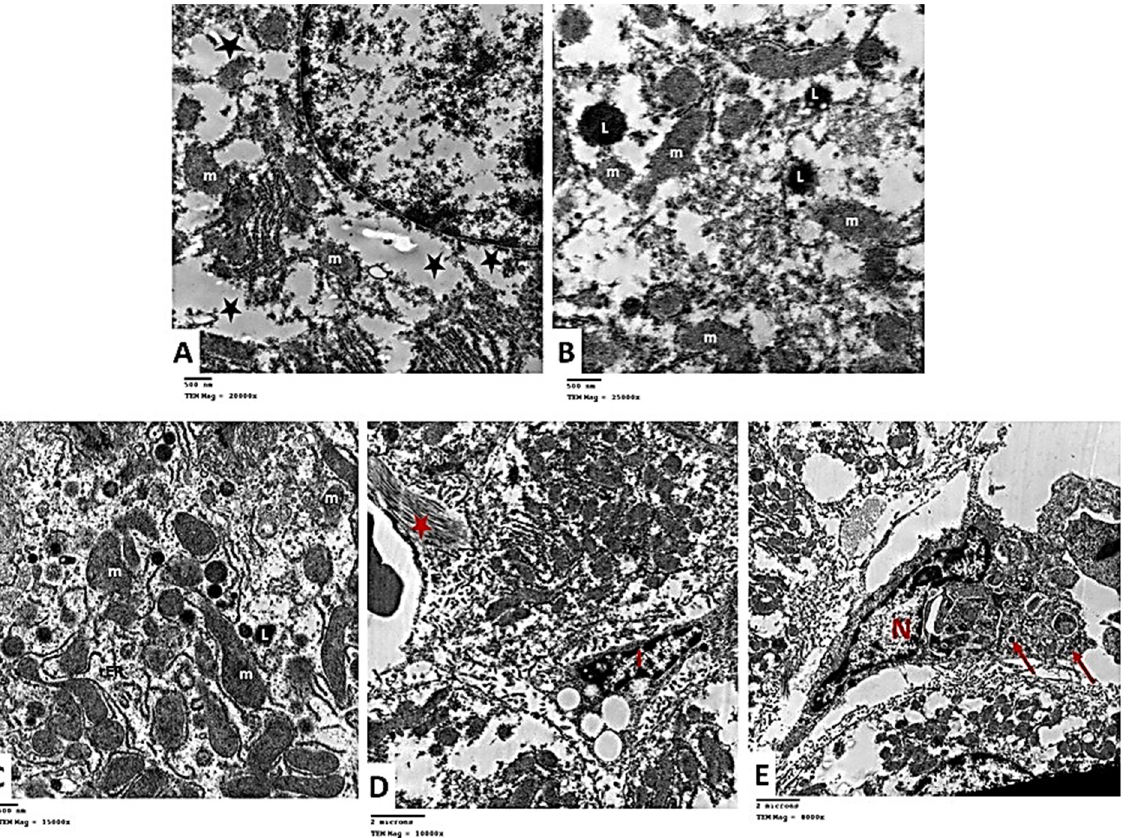
Figure 12. ( A ) Electron micrographs of Group II showing homogenous echogenic areas in hepatocyte cytoplasm (*). TEM × 20,000. ( B ) Electron micrograph showing the apparent decrease in rER and glycogen rosettes. Many lysosomes (L) are seen scattered in the cytoplasm. Mitochondria (m) are seen with an ill-defined outer membrane. Degeneration and lysis of the organelles are also noticed. TEM × 250,000. ( C ) showing swollen mitochondria (m), which lose their cristae. Expansion of rough endoplasmic reticulum (rER) is seen with loss of the attached ribosomes. TEM × 15,000. ( D ) Electron micrograph showing hepatic stellate cell or Ito cell (I) containing fat droplets in its cytoplasm. Notice the collagen fibers with their axial periodicity (*). TEM × 10,000. ( E ) Electron micrograph showing Kupffer cell with large irregular nucleus (N) and many micro-vesicles and phagocytosed material ( ↑ ) in the cytoplasm. TEM × 8000.